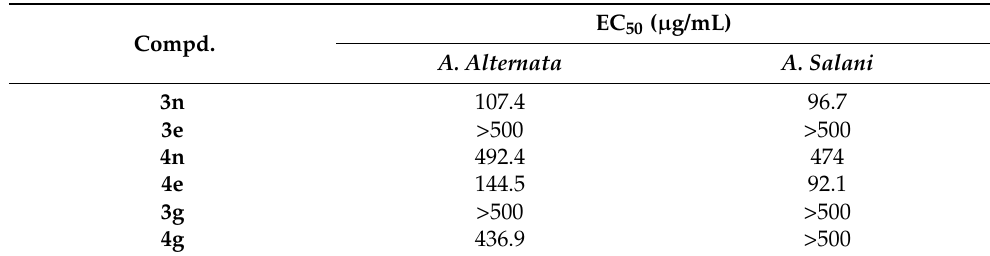
Table 3. In vitro EC 50 values of selected compounds against A. Alternata and A. Salani at 200, 100, 50, 25, and 12.5 µ g/mL.